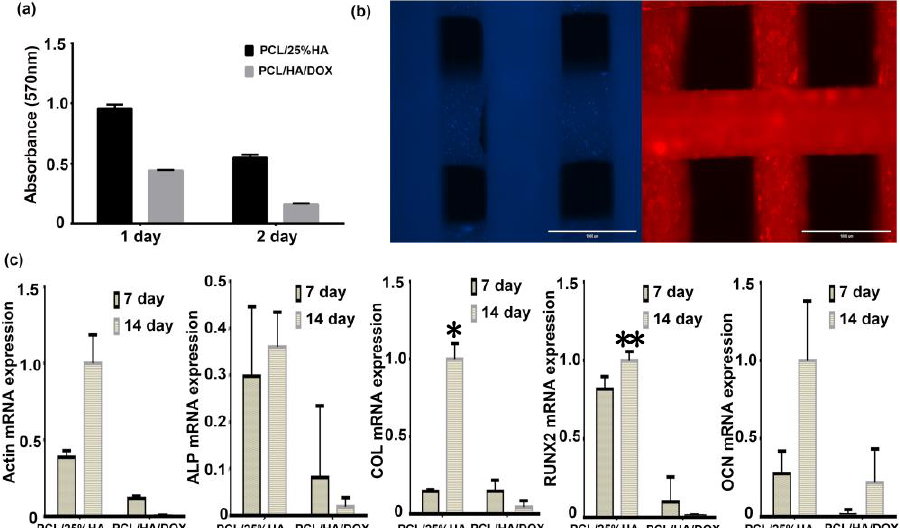
Figure 7. In vitro cell biocompatibility of BMSCs with scaffolds. ( a ) Cell proliferation results of BMSCs after culturing for 1 or 2 days on the PCL/25%HA and PCL/HA/DOX scaffolds, ( b ) Fluorescence morphologies of cells grown on PCL/25%HA scaffolds after 2 days, and ( c ) the expression of Actin, ALP, COL, RUNX2, and OCN mRNA of PCL/25%HA and multi − functional PCL/HA/DOX scaffolds to BMSCs. * p < 0.05, ** p < 0.01, vs. PCL/25%HA.